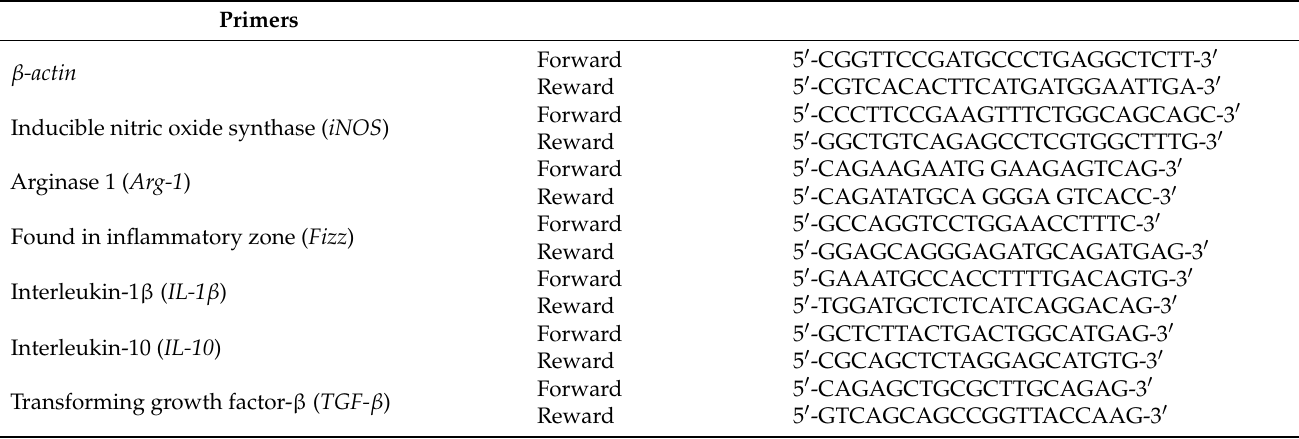
Table 1. List of the primers for macrophage polarization and glycolysis pathway are demonstrated.